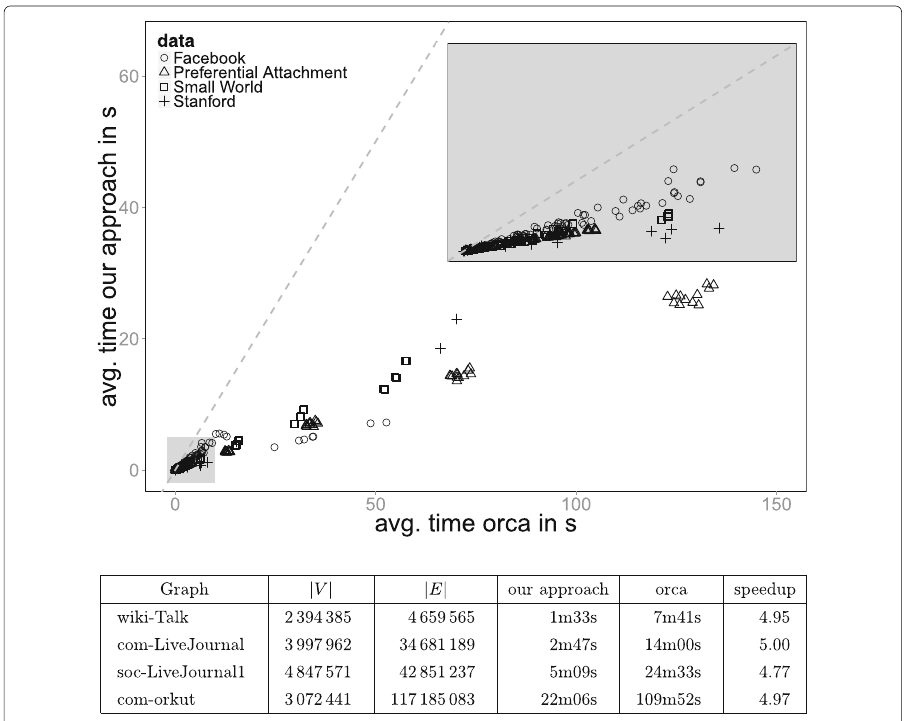
Fig. 6 Top : Avg. running time of orca vs. avg. running time of our approach in seconds for all but the largest SNAP graphs. Dots below the main diagonal indicate that the algorithm on the y-axis is faster. Embedded plot displays gray area in higher resolution. Bottom : Time comparison for the largest SNAP graphs